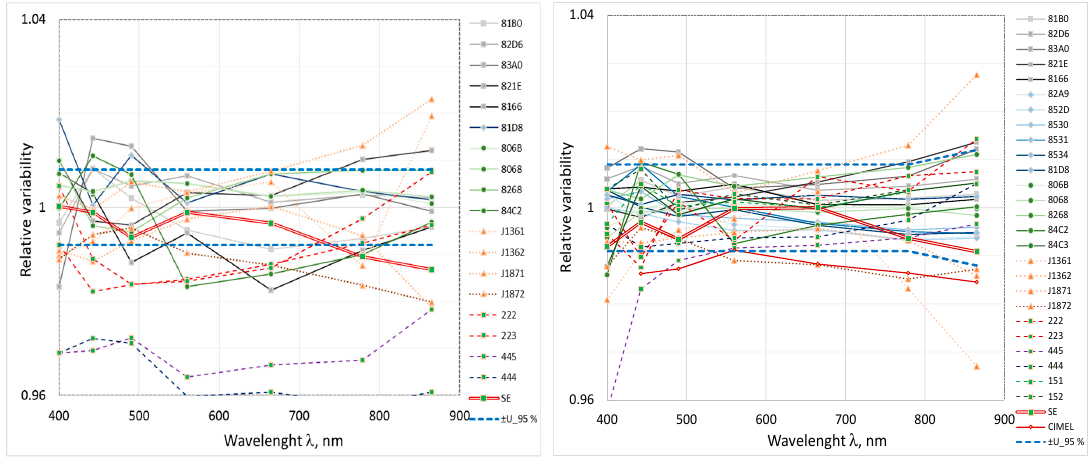
Figure 6. High intensity radiance; agreement just after receiving data from participants (left), and after reviewing data by pilot, corrections submitted by participants and/or unified data handling by pilot (right).